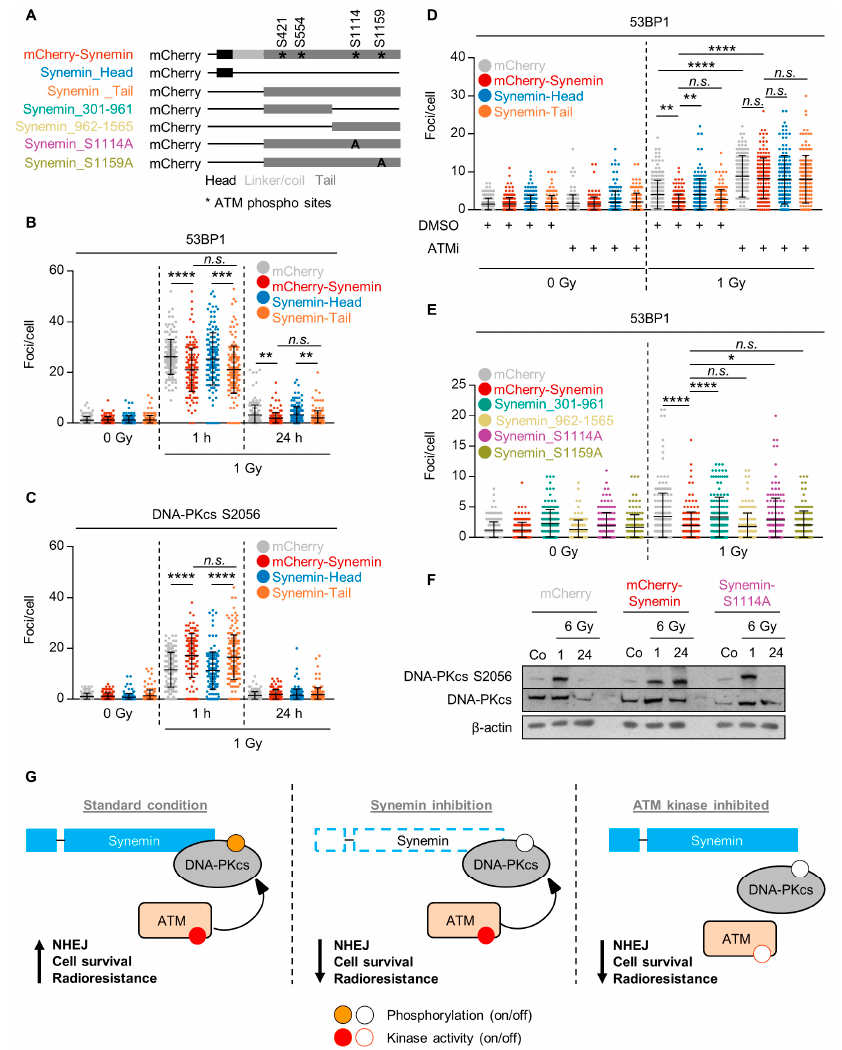
Figure 6. Synemin-mediated DNA repair depends on the S1114 phosphorylation site of synemin. ( A ) Design of different synemin constructs; ( B , C ) 53BP1 and DNA-PKcs S2056 foci kinetics in 1-Gy X-ray-irradiated SAS cells expressing mCherry–Synemin wildtype, mCherry–Synemin_Head or mCherry–Synemin_Tail (mCherry was used as control); ( D ) Residual 53BP1 foci (24 h after irradiation) in (mCherry was used as control) treated with ATMi and 1-Gy X-rays; ( E ) Residual 53BP1 foci (24 h after irradiation) in 1-Gy X-ray-irradiated SAS transfectants expressing mCherry–Synemin